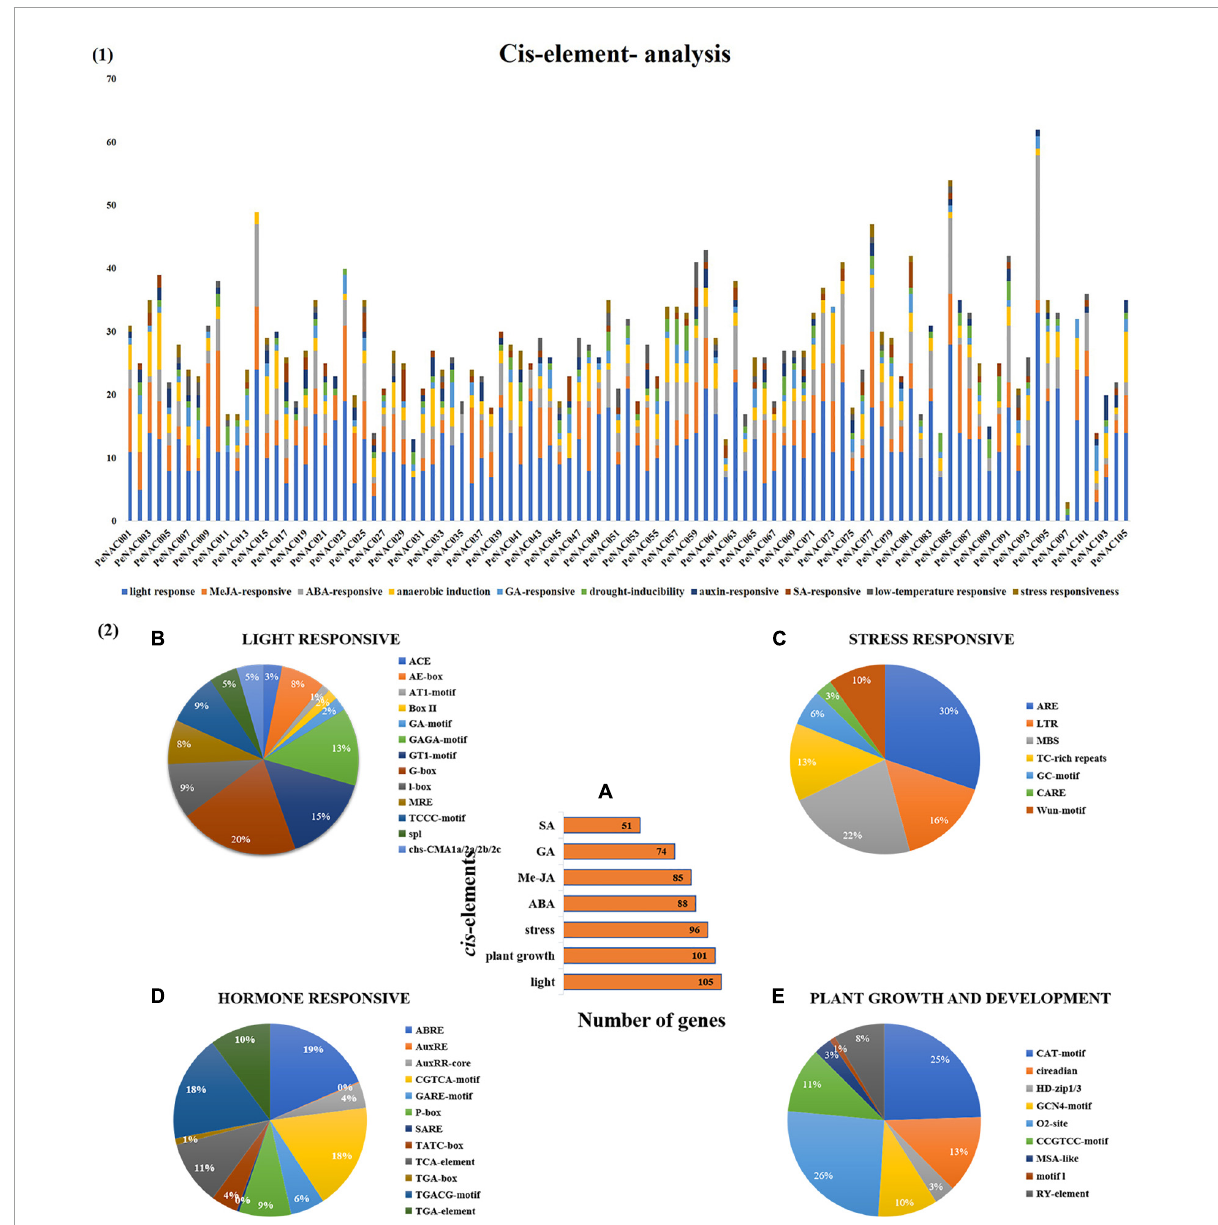
FIGURE3 The cis -regulatory element analysis of PeNAC genes (A) . (A) The sum number of PeNAC genes involved in four categories of cis -elements and the percentage (%) ratio of the numerous cis -elements from each category is presented in pie charts; (B) light-responsive; (C) stress-responsive; (D) hormone-responsive and (E) plant growth and development. Different colors indicate different cis -elements and their ratios present in PeNAC